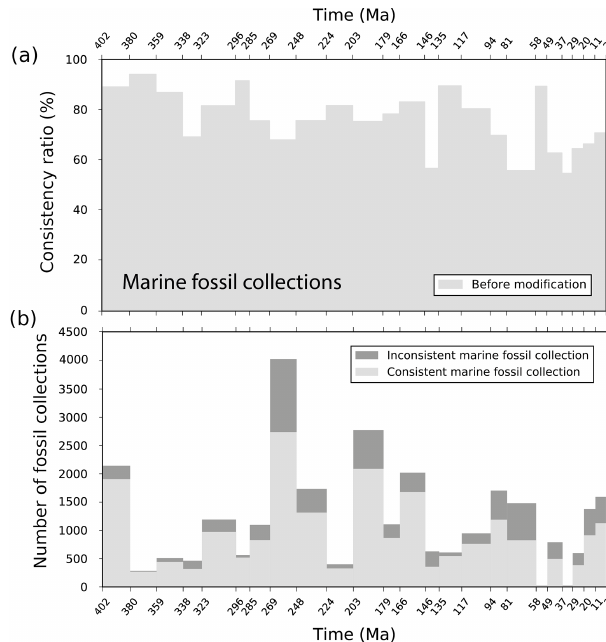
Figure 6. (a) Consistency ratios between global paleogeography with gap filled, but before PBDB test for the period 402–2Ma, re- constructed using the plate motion model of Matthews et al. (2016) and the paleoenvironments indicated by the marine fossil collec- tions from the PBDB. (b) Numbers of consistent (light grey) and inconsistent (dark grey) marine fossil collections used in the tests for each time interval from 402 to